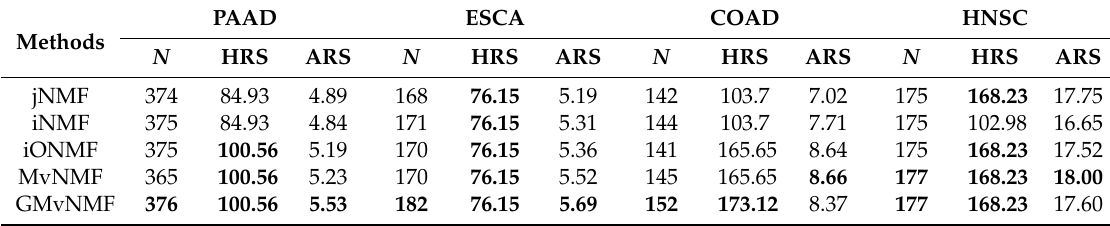
Table 4. Co-differential genes selection results on four multi-view